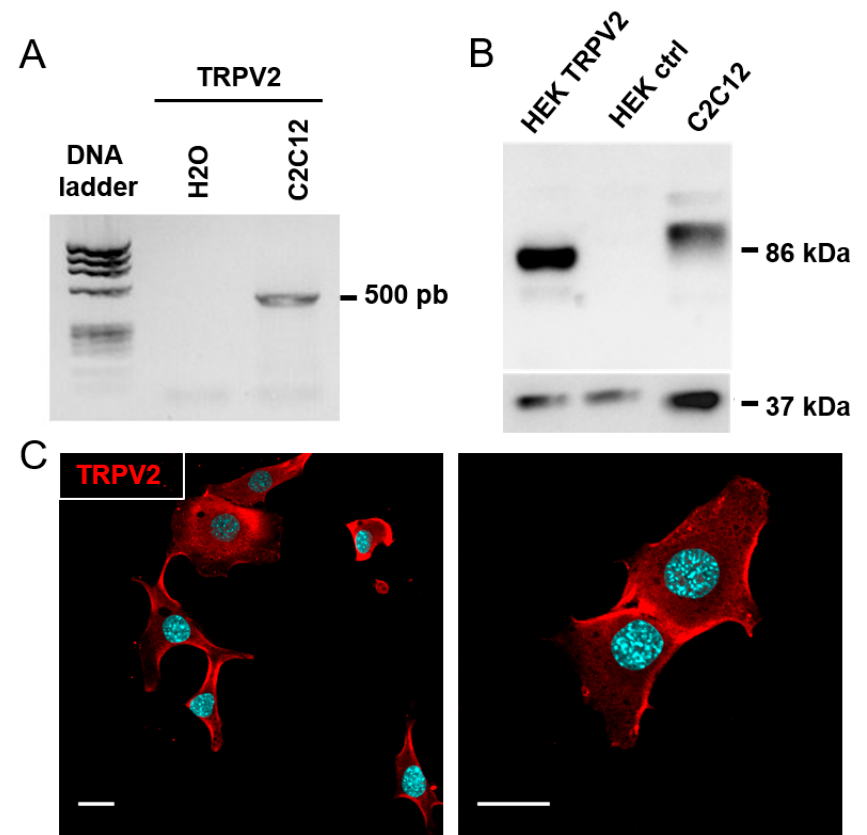
Figure 3. Expression of transient receptor potential vanilloid 2 (TRPV2) channels in C2C12 myoblasts. ( A ) Assessment of TRPV2 mRNA expression in C2C12 myoblasts by RT-PCR. ( B ) Western blot analysis of TRPV2 and GAPDH expression in C2C12 myoblasts, human embryonic kidney (HEK)293 cells stably expressing TRPV2 (HEK TRPV2), and control HEK293 cells (HEK ctrl). TRPV2 and GAPDH were detected sequentially on the same blot (stripped twice). 5 µ g of proteins were deposited for HEK cell lysates and 10 µ g for C2C12 myoblasts ( n = 4). ( C ) Confocal images at two magnifications showing immuno-localization of TRPV2 (red) and nuclei staining (blue) in C2C12 myoblasts (scale bar: 20 µ